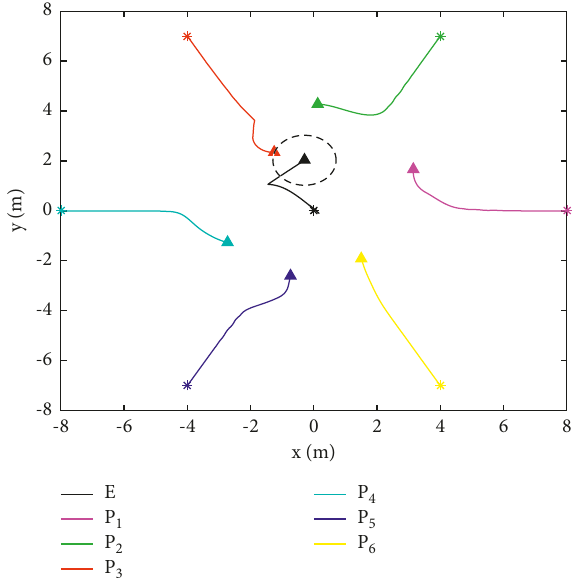
Figure 3: Trajectories of the players with cooperative hunting strategy ( N � 6, λ � 0 . 85). The pursuer 2 captures the evader.